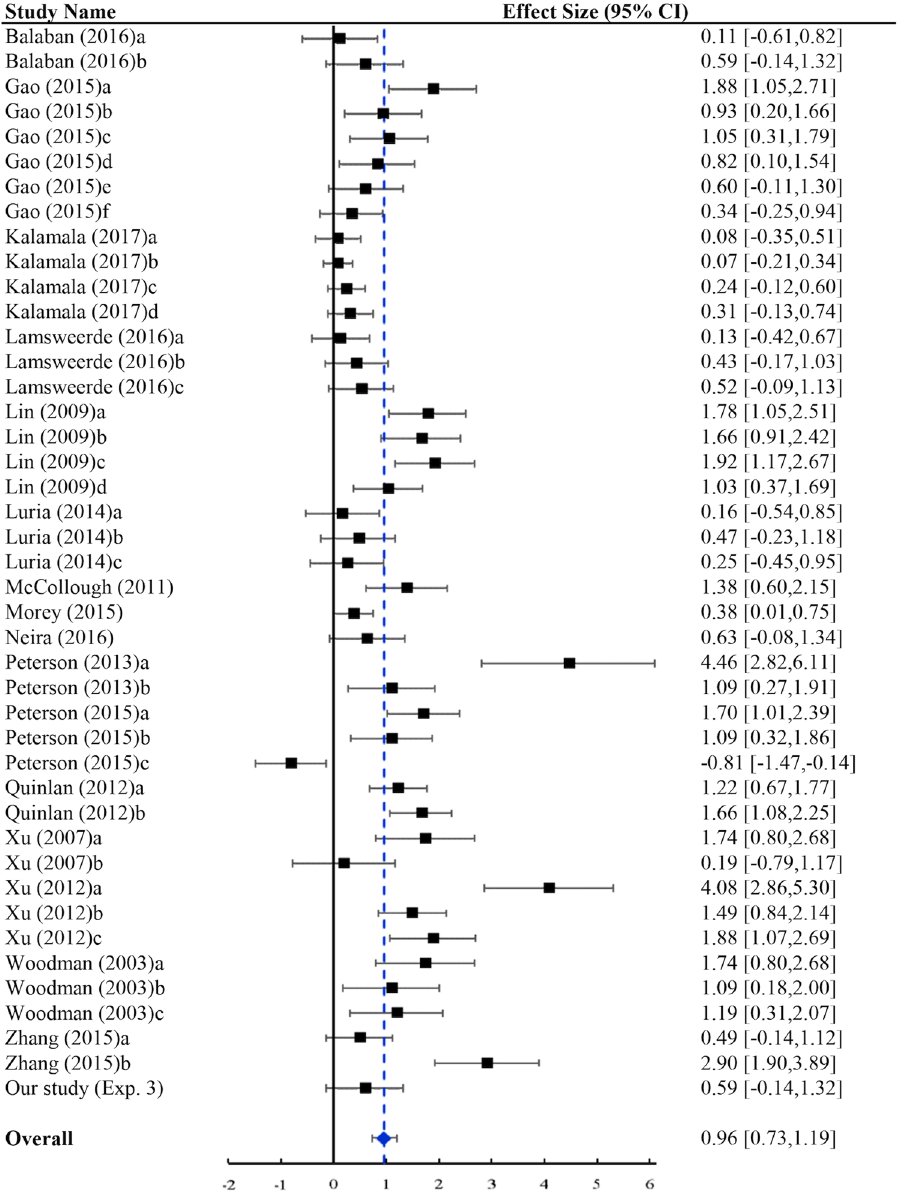
Figure 6. Overall effect of grouping on visual working memory. For the individual studies, the size of the square indicated the weight for the effect size in each study, and the line indicated the 95% CI of each effect size; for the overall effect, the width of the diamond indicated the 95% CI of the overall effect size, and the line indicated its 95% prediction